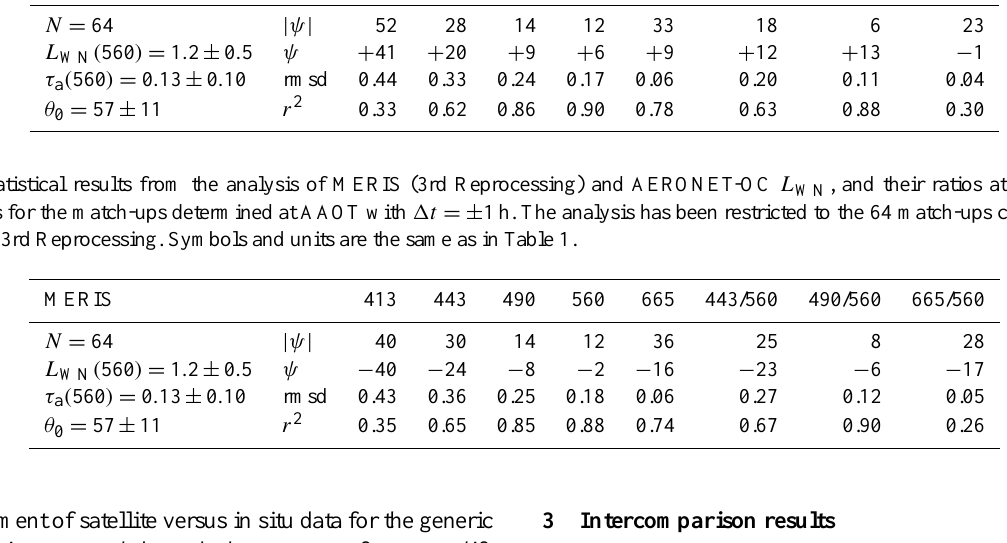
Table 3. Statistical results from the analysis of MERIS (2nd Reprocessing) and AERONET-OC L WN , and their ratios at specific center wavelengths for the match-ups determined at AAOT with 1t = ± 1h. The analysis has been restricted to the 64 match-ups common to both the 2nd and 3rd Reprocessing. Symbols and units are the same as in Table 1. MERIS 413